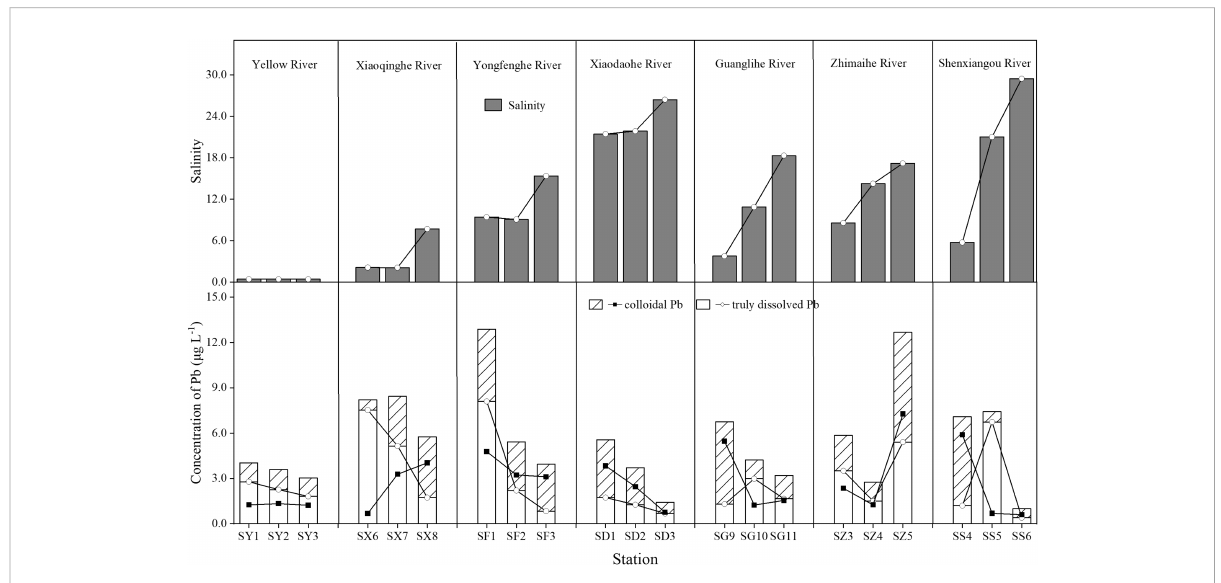
FIGURE 7 Changes in the trend of total dissolved lead (Pb) with the increase of salinity in different